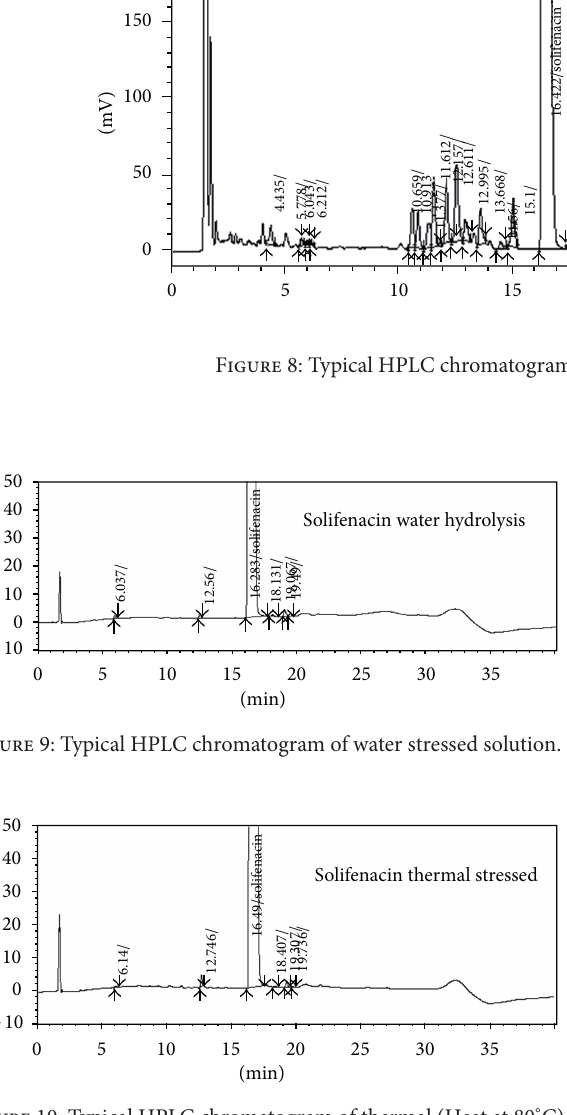
F 10: Typical HPLC chromatogram of thermal (Heat at 80